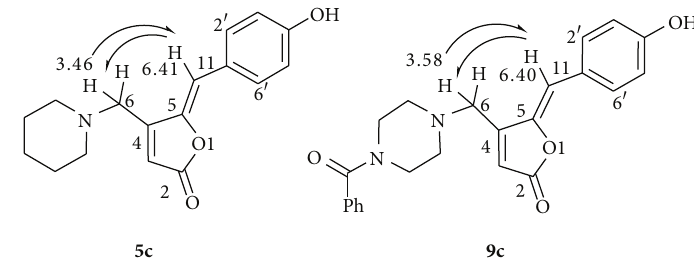
Figure 2: The NOE spectra of compounds 5c and 9c .